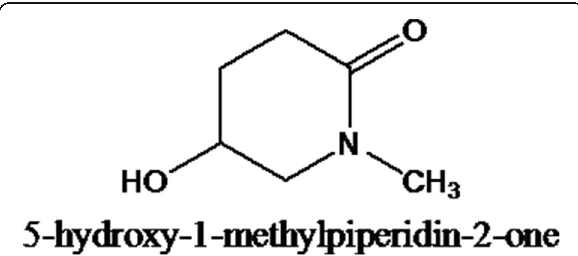
Fig. 1 Structure of 5-hydroxy-1-methylpiperidin-2-one. The molecular weight and molecular formula are 129.16 and C 6 H 11 NO 2